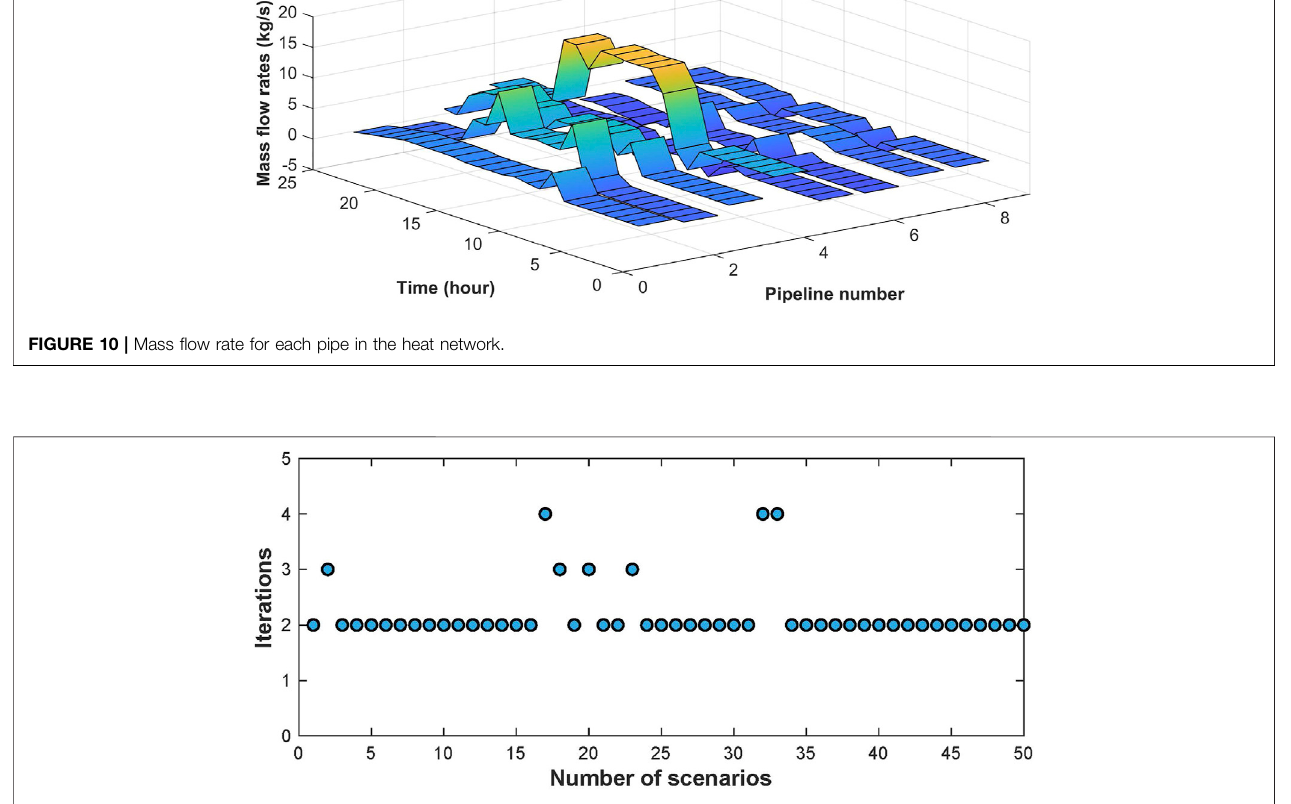
FIGURE 11 | Iterations of the proposed method in scenarios of fl uctuating loads.